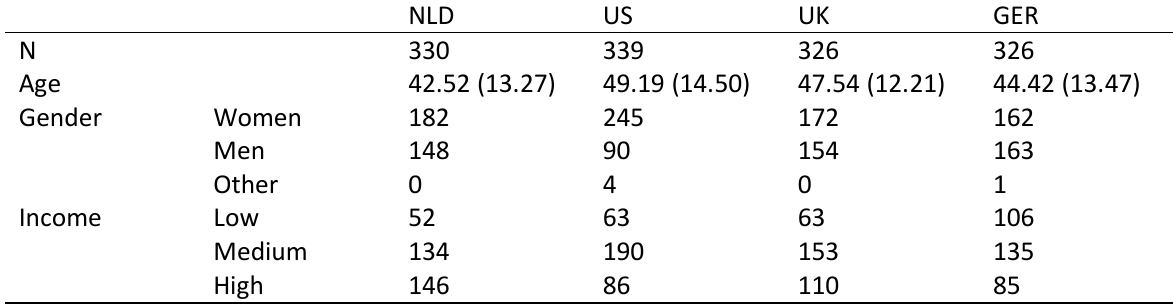
Table A1 . Sample composition per